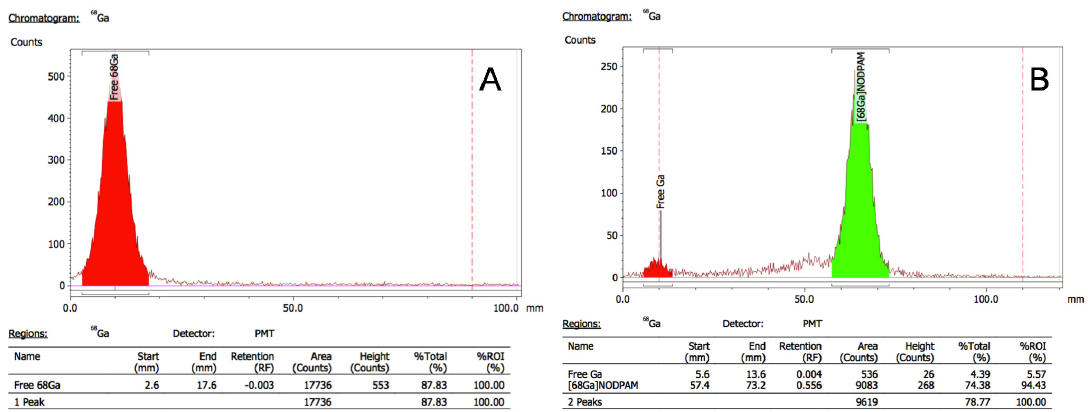
Figure 13. Radiochemical purity analysis for [ 68 Ga]Ga ‐ NODPAM using TLC ‐ SG (silica gel) plate and 0.4 M phosphate:acetonitrile (7:3) as the mobile phase ( A )—Free gallium-68; ( B )—Radiolabeled [ 68